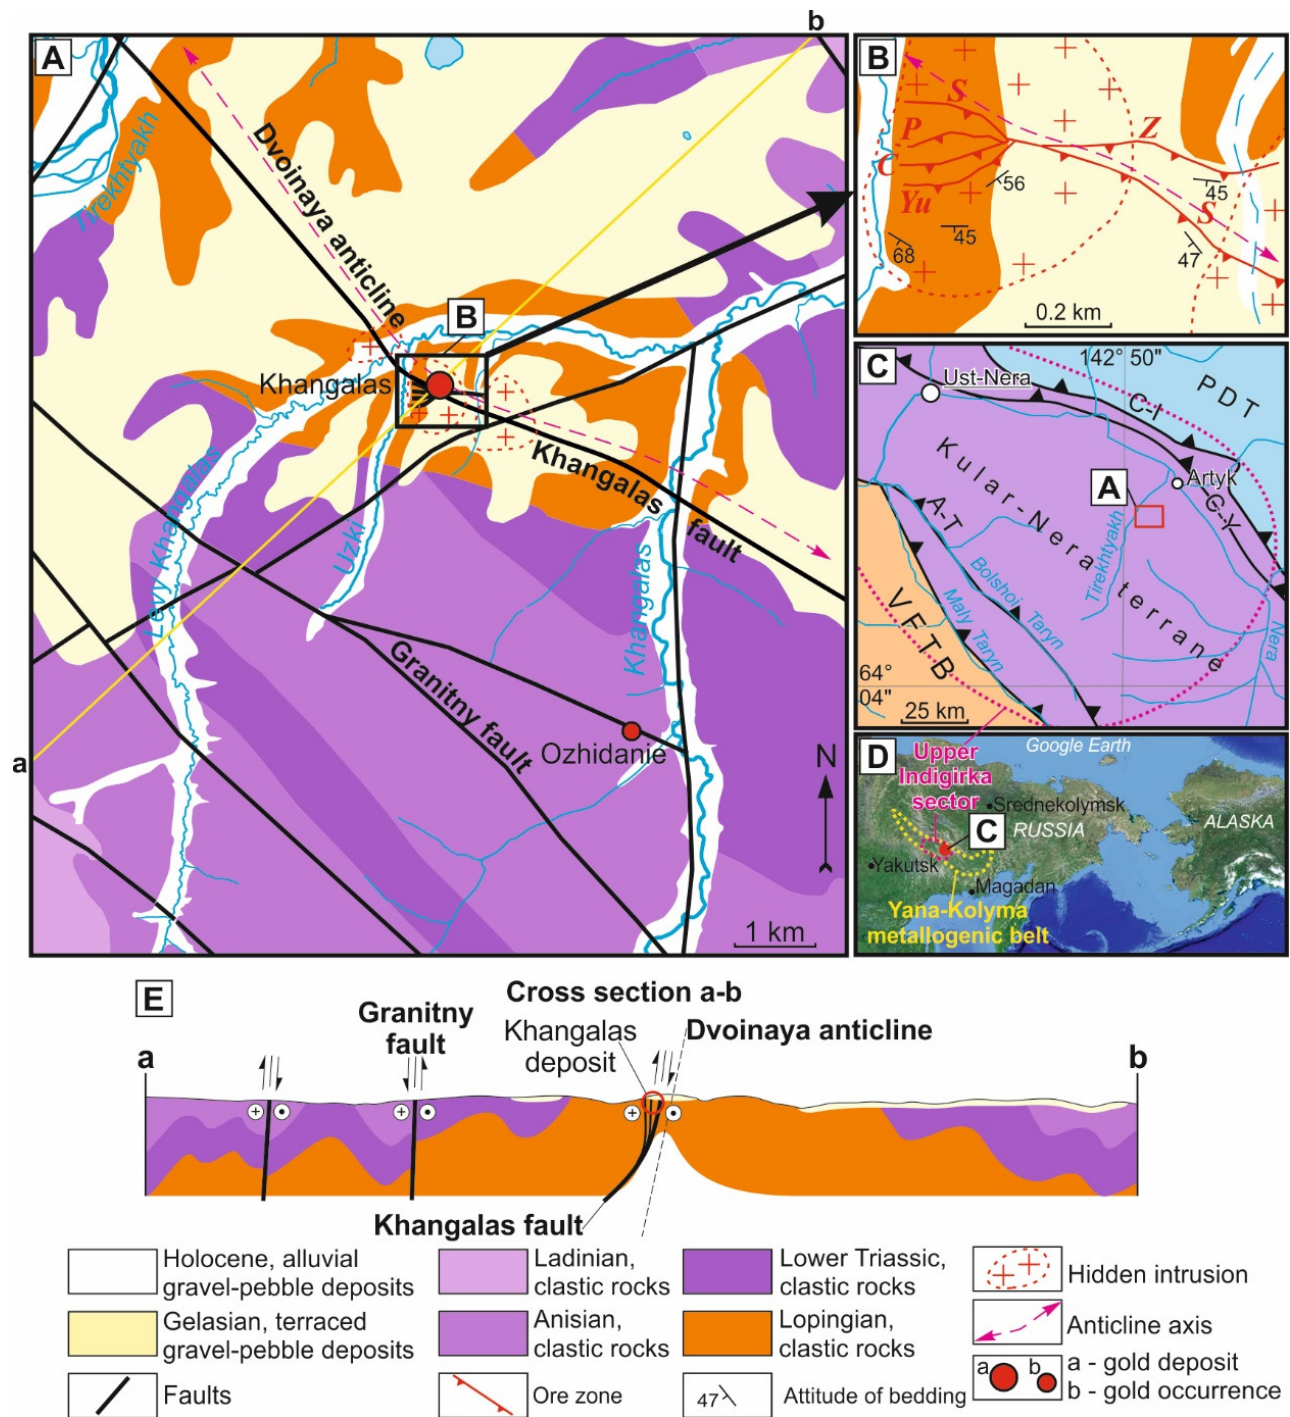
Figure 1. ( A,C,D ) Regional location, ( B ) geological structure, and ( E ) cross-section of Khangalas deposit. Inset map: VFTB, Verkhoyansk fold-and-thrust belt; PDT, Polousny–Debin terrane; C-I, Charky–Indigirka fault; C-Y, Chai–Yureya failt; A-T, Adycha–Taryn fault. Mineralized crushed zones: S, Severnaya; P, Promezhutochnaya; C, Centralnaya; Yu, Yuzhnaya; Z, Zimnyaya.